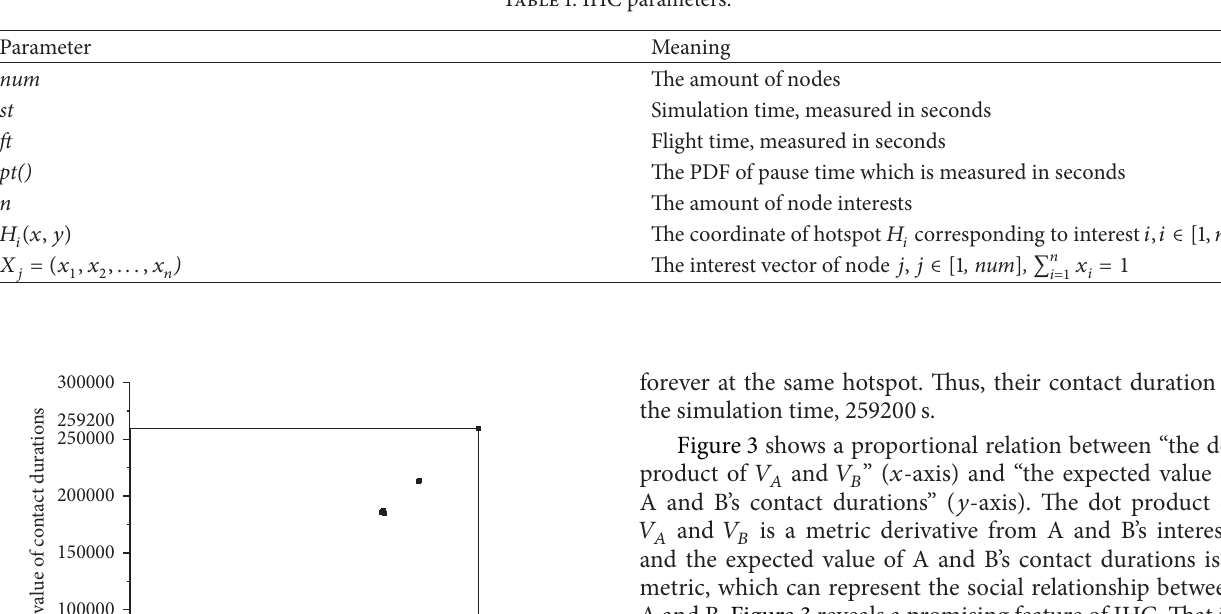
Table 1: IHC parameters.